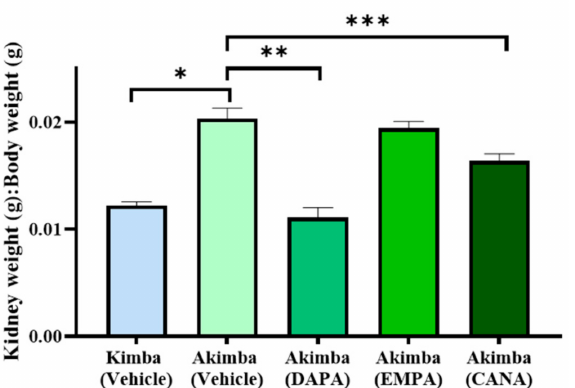
Figure 5. Effect of SGLT2 inhibition on kidney to body weight ratio (KW/BW) in diabetic Akimba mice. Data represented as mean + SEM, n = 3–18 mice/group. Using One-way ANOVA * p < 0.0001 (Kimba Vehicle vs. Akimba Vehicle); ** p ≤ 0.0001 (Akimba DAPA vs. Vehicle); *** p ≤ 0.006 (Akimba CANA vs. Vehicle). DAPA: Dapagliflozin; EMPA: Empagliflozin and CANA: